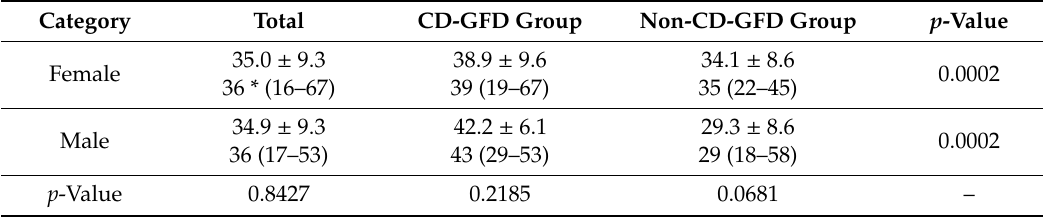
Table 3. Food Neophobia Scale (FNS) scores stratified by gender in the sub-groups of CD-GFD and non-CD-GFD individuals (mean ± SD and median accompanied by range).